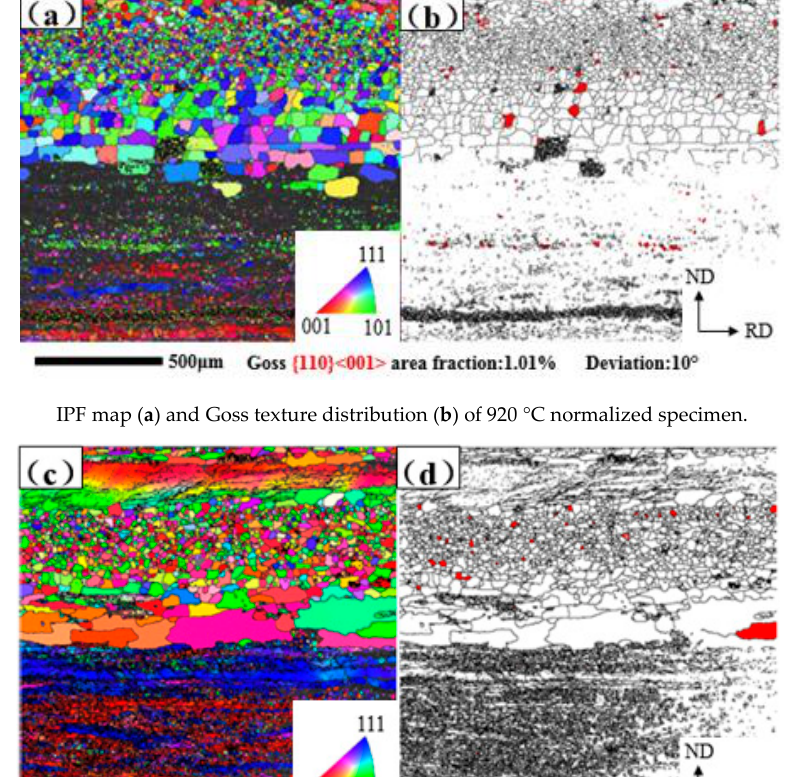
Figure 5. Mean size of the precipitates in the normalized and decarburized specimens.